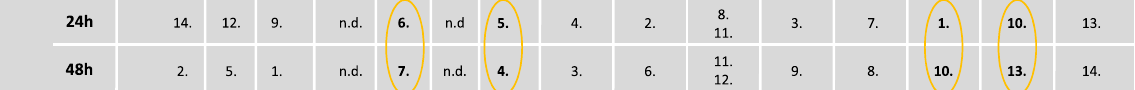
Figure 2. FDXR results. Display of TaqMan assay arrangement on a schematic image of FDXR (note: size ratio of exons to each other is not accurate), baselines and differential gene expression after 0.5 Gy and 4 Gy after 24 h and 48 h. At the bottom of the figure, the inter-individual variability is shown. The assay with the lowest sum of the standard deviation of the FCs over all dose categories is ranked 1st. Correspondingly the assay with the highest sum is ranked last. Starting with the baseline and working downwards, the assays meeting the criteria defined in the material and methods are circled. For illustration, the inter-individual variability of the TaqMan assays identified using the other criteria (baseline, dose dependency, time persistency) are circled in orange. The four encircled assays on the schematic image of FDXR are the ones most suitable for biodosimetry purposes. Asterisks mark the best coverage assay. Assay labels starting with the two capital letters “AR” can be found after creating an account at Thermo Fisher web site, entering the “Reorder Custom Assays” section with the implemented search function in the “Custom TaqMan Assay Design Tool”. n.d. not